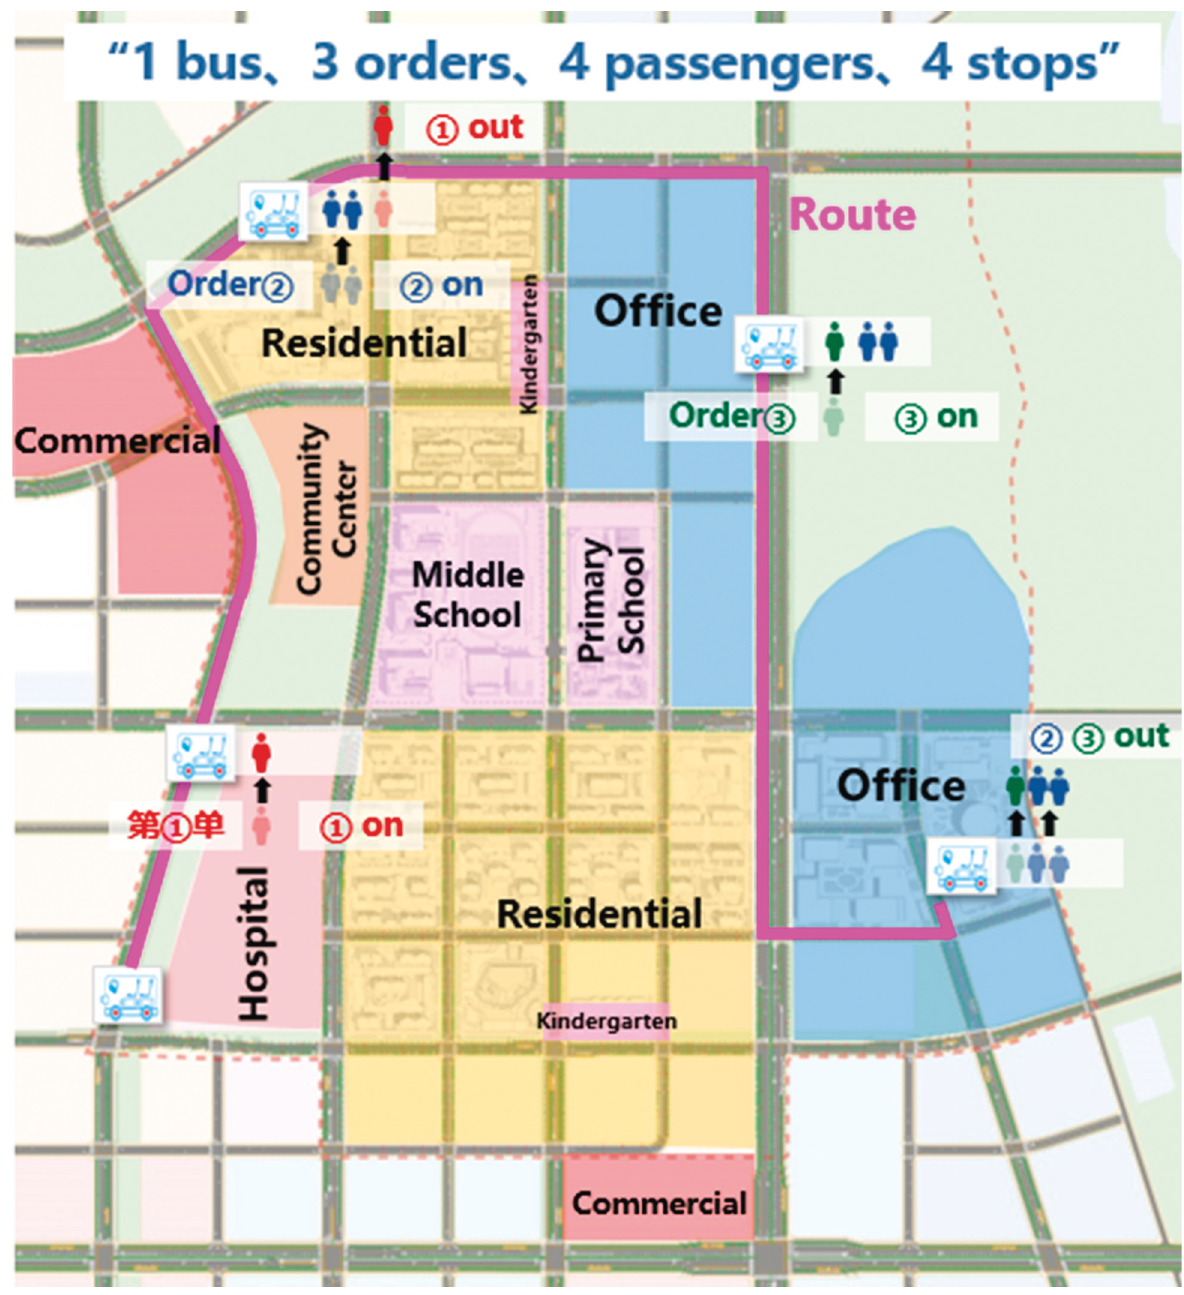
Figure 2: Example of DR bus